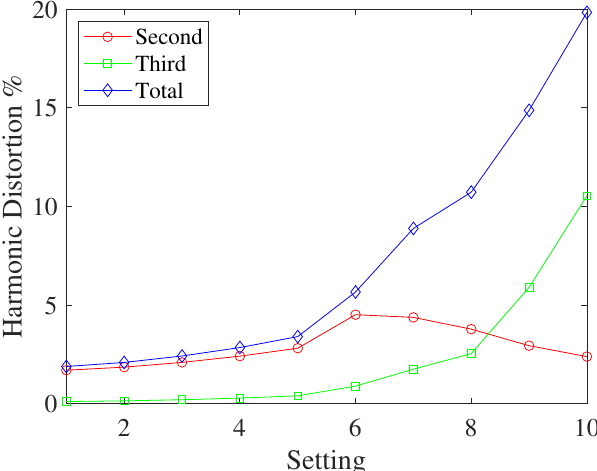
Figure 2. Second, third, and total harmonic distortion of the Behringer MIC100 preamplifier at the different